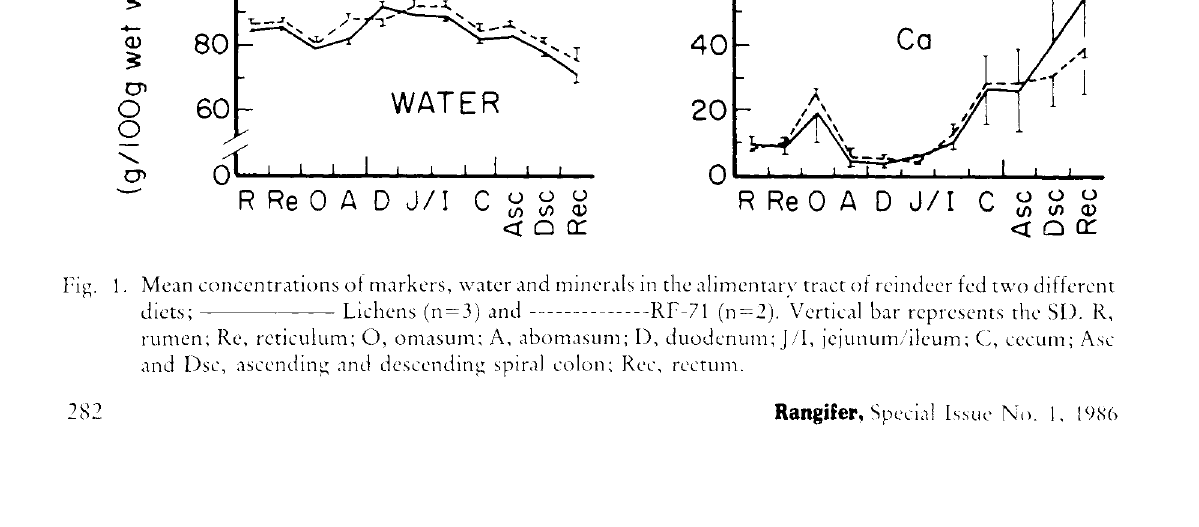
Fig. 1. Mean concentrations of markers, w r ater and minerals m the alimentary tract of reindeer fed two different diets; Lichens (n = 3) and RF-71 (n = 2). Vertical bar represents the SD. R, rumen; Re, reticulum; O, omasum; A, abomasum; D, duodenum; J/I, jejunum/ileum; C, cecum;